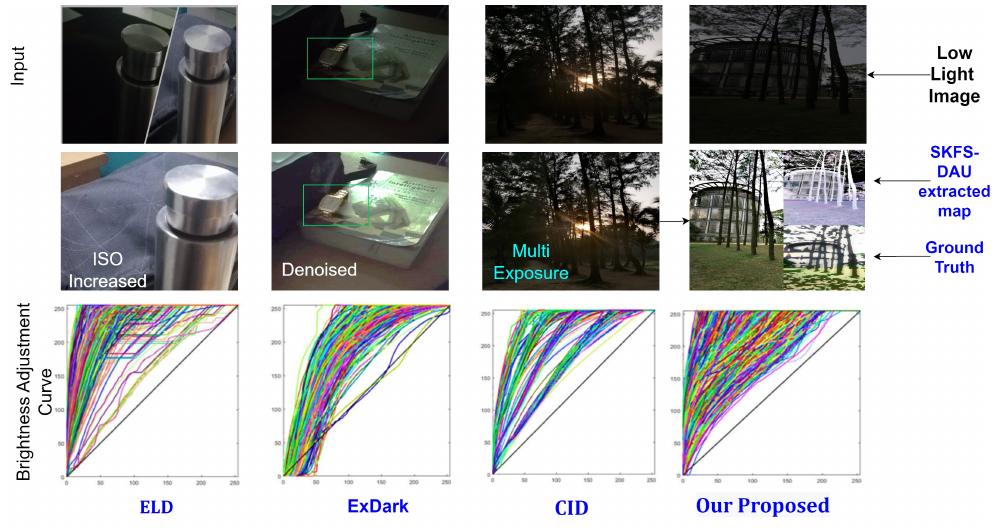
Figure 2. Visual comparison of low-light enhancement approaches, ELD [20], ExDark [15], CID [21], Our proposed model